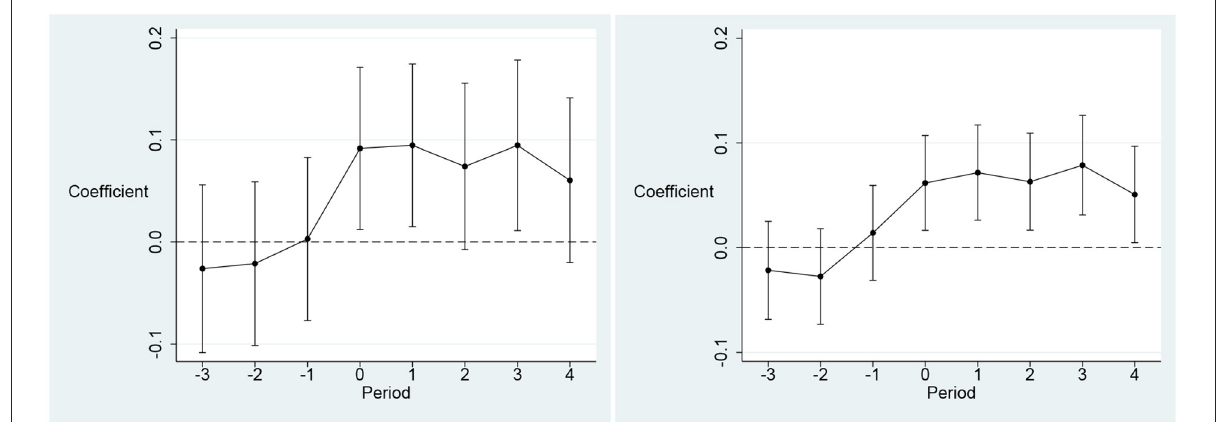
FIGURE2 Results of Parallel Trend Test. The dependent variable in the left panel is healthcare workforce (ln phe 1) and the dependent variable in the right panel is healthcare infrastructure (ln phe 2). The X-axis denotes the window period for YRDE implementation. The Y axis denotes the coefficient of YRDE. The year before YRDE is implemented as the base